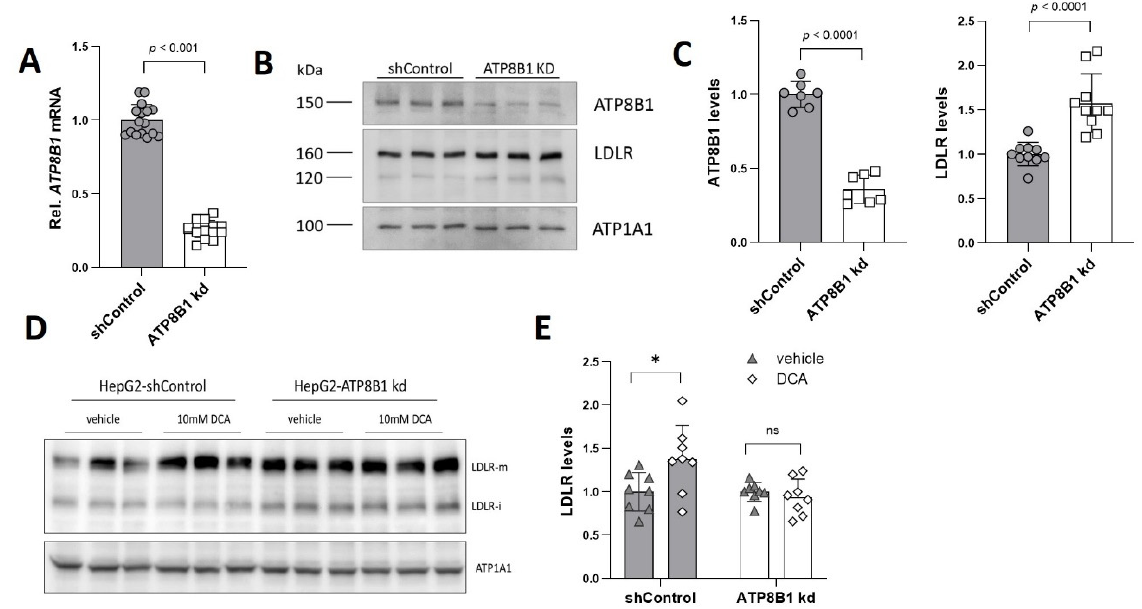
Figure 1. ATP8B1 knockdown coincides with increased LDLR expression. ( A ) ATP8B1 mRNA expression in ATP8B1 knockdown HepG2 cells. Data were normalized to shControl cells and are expressed as means +/ − s.e.m. of 16 replicates from 5 independent experiments. Statistical analysis by an unpaired t -test.; ( B ) LDLR protein levels are increased in ATP8B1 kd HepG2 cells. Western